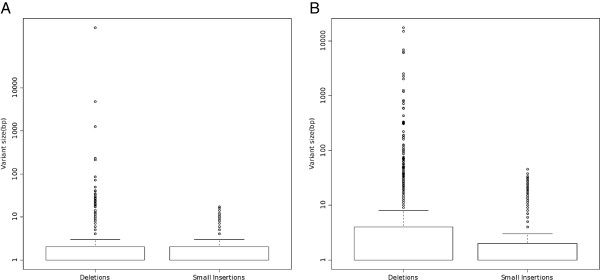
Evaluation of structural variant discovery. Boxplots showing size of deletions and small insertions identified using SHS-PE (A) and FS (B) sequence data. In all cases, the median variant size is 1 (the lowest line). The top of the box is the 75th percentile, and the whisker is the highest value still less than the 75th percentile + (1.5 * interquartile range). Note the y-axis uses a log scale. A 25 Mb (SHS-PE) and a 27Mb (FS) deletion were omitted, as they were far outliers that appeared to be false positive determinations.